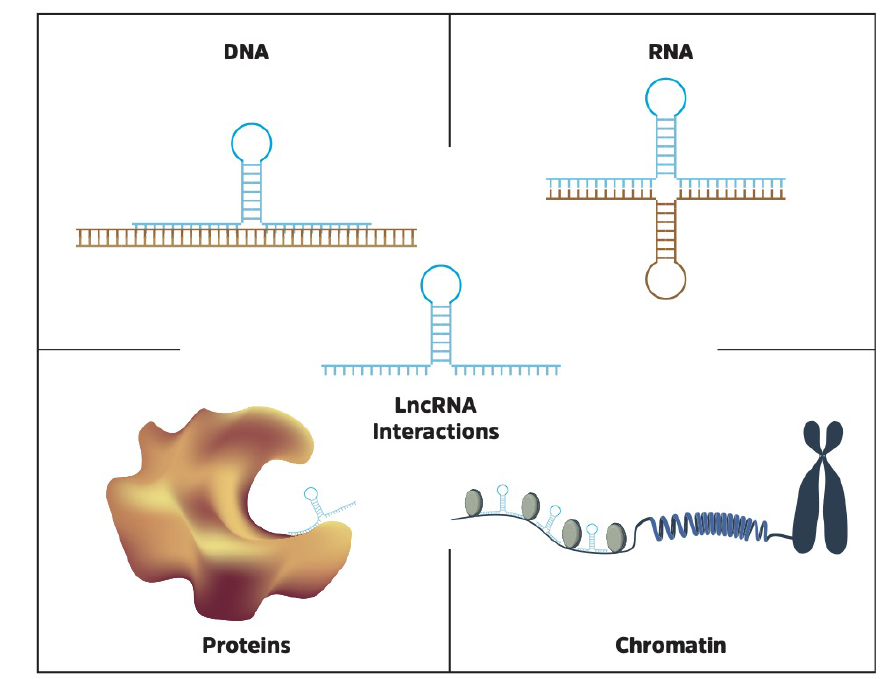
Figure 3. LncRNAs interact with a variety of biological molecules, including DNA, RNA, proteins and